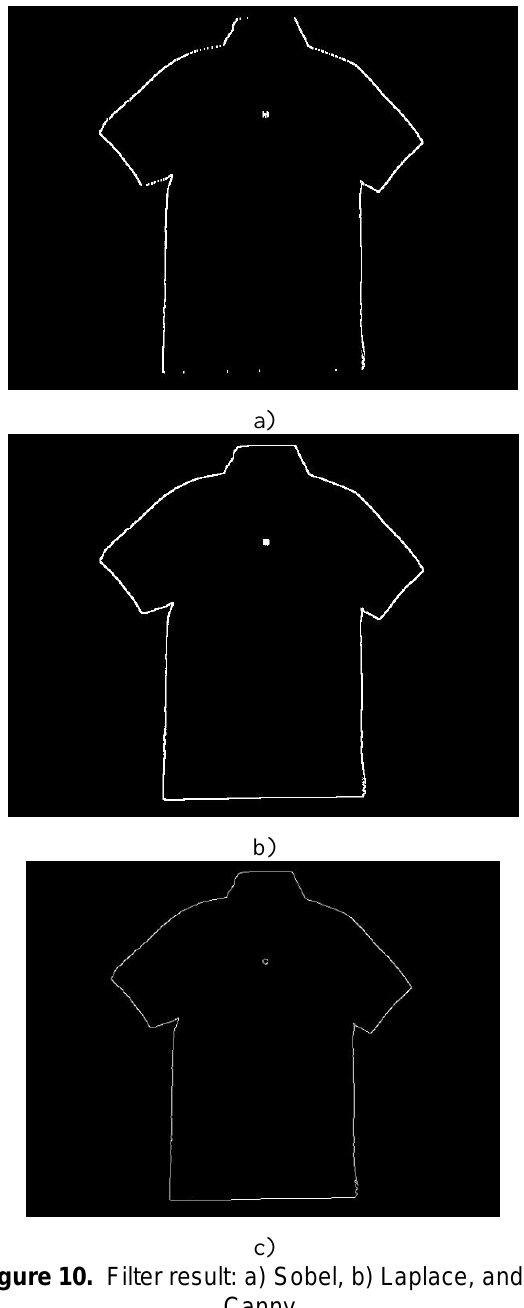
Figure 9. Image boundary profiles: a) ideal profile, b) stepped profile, and c) real profile.